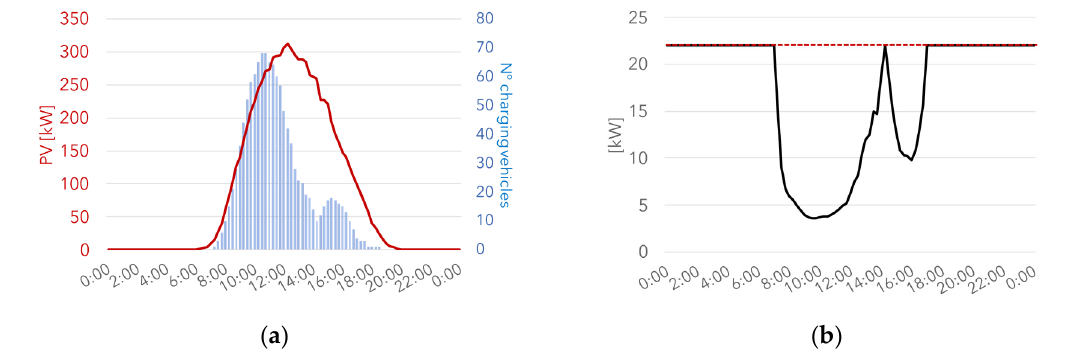
Figure 13. Input and output CMS (SA) parameters: ( a ) the PV power measurement ( red ) and the number of EVs charging ( blue ); ( b ) the output reference power for each charging station.